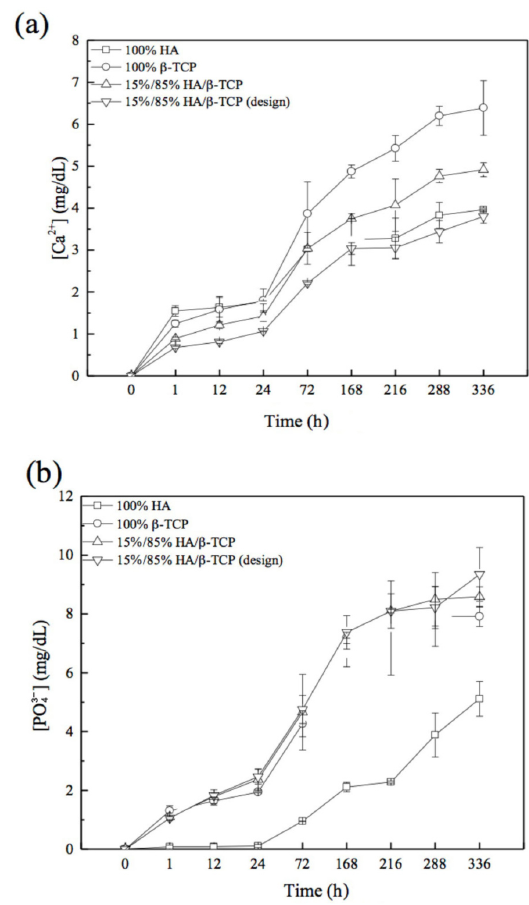
Fig. 5 These XRD spectra are for groups (a) 100% HA, (b) 100% β-TCP, (c) 15%/85% HA/β-TCP, and (d) 15%/85% HA/β-TCP (design) and are a comparison among the six time points in vitro : (i) initial, (ii) 1 day, (iii) 7 days, (iv) 14 days, (v) 21 days, and (vi) 28